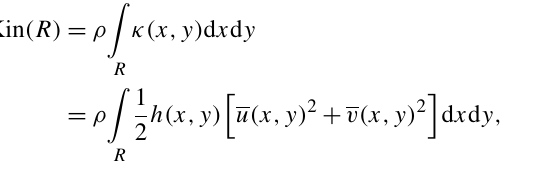
where hu and hv are the components of momentum in the x and y